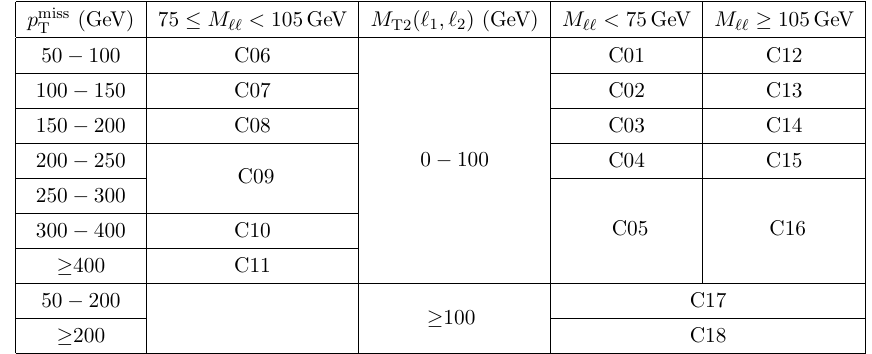
Table 4 . Search region de(cid:12)nition corresponding to category C, events with two e or (cid:22) forming an opposite-sign same-(cid:13)avor (OSSF) pair and one (cid:28) h candidate. Regions where there is a Z boson candidate are not split into M T2